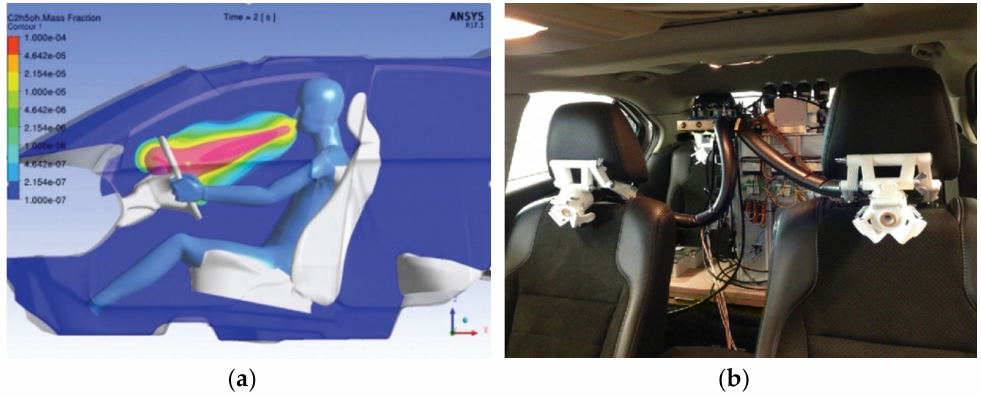
Figure 1. Autoliv breath alcohol sensing system. ( a ) Simulated view of the gas path from the driver to the sensor on the steering wheel. ( b ) Prototype placement of the sensors in the car.